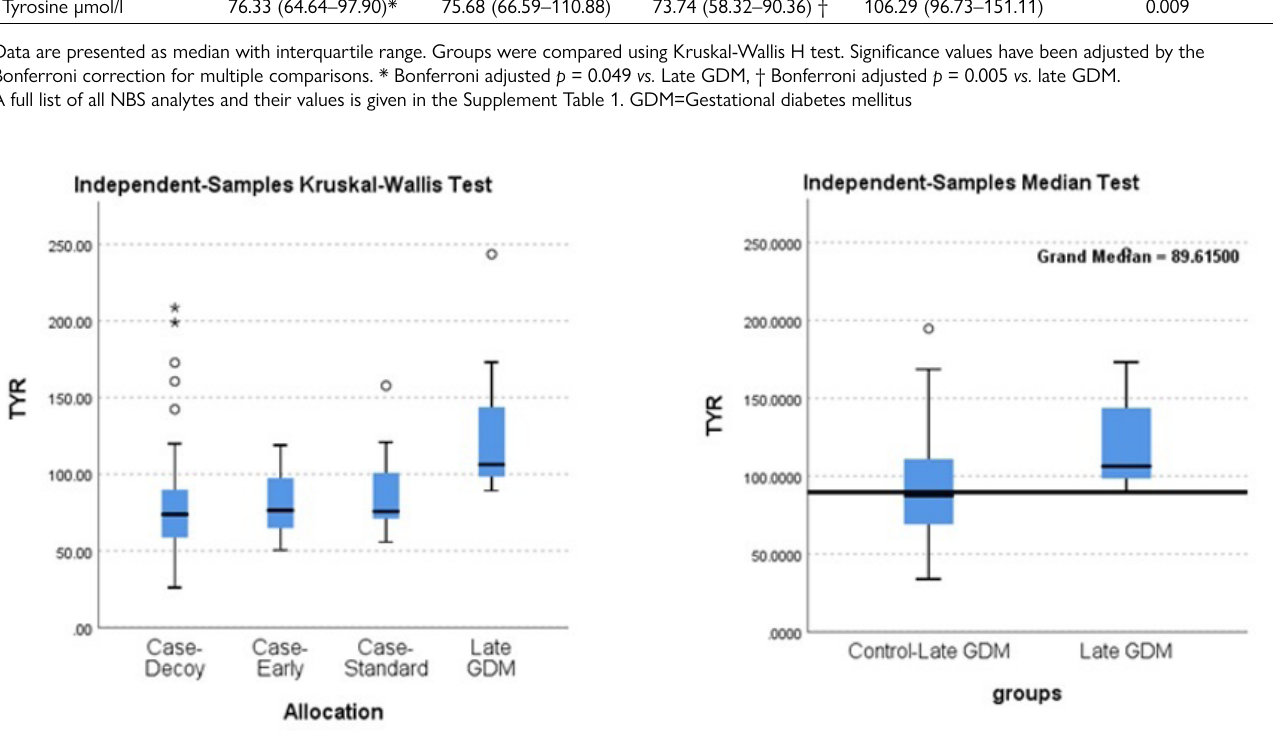
Figure 2. Comparison of tyrosine levels in the late GDM group versus early treatment, deferred treatment and decoy groups and between late GDM cases and